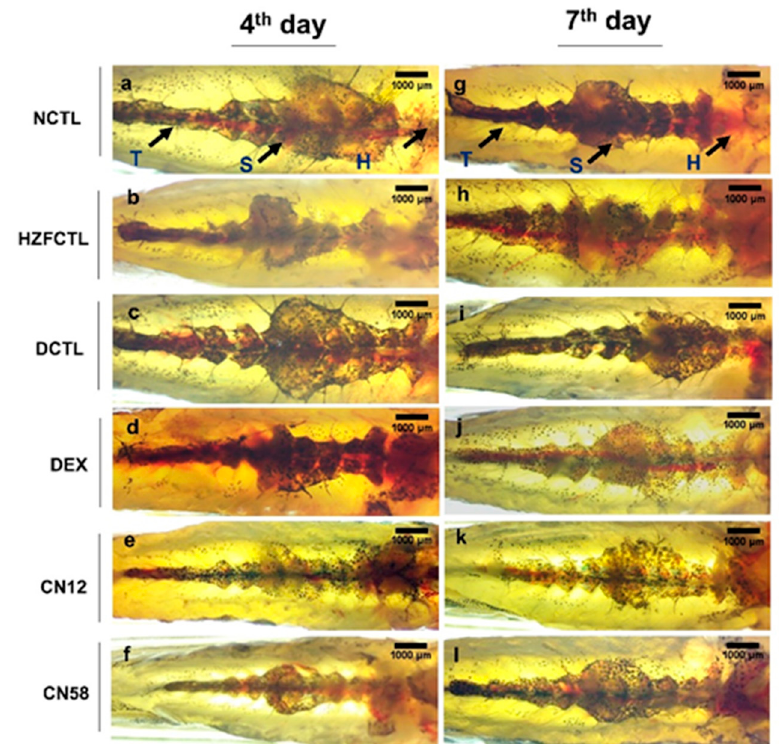
Figure 6. Gross anatomy of kidney to test the effect of SARS-CoV-2 spike protein and Coronil on renal architecture. ( a ) NCTL at 4th day, ( b ) HZFCTL at 4th day, ( g ) NCTL at 7th day, (h ) HZFCTL at 7th day. ( c , i ) DCTL with lost tubular segmentation and vascular degeneration. ( d , j ) DEX. ( e , f ) CN12 and CN58 of 4th day group exhibiting normal renal morphology. ( k ) CN12 showed normal renal Head; S—Saddle; T—Tail of kidney. n = 24 for each test group, scale bars, 1000 µm at 1X magnification.